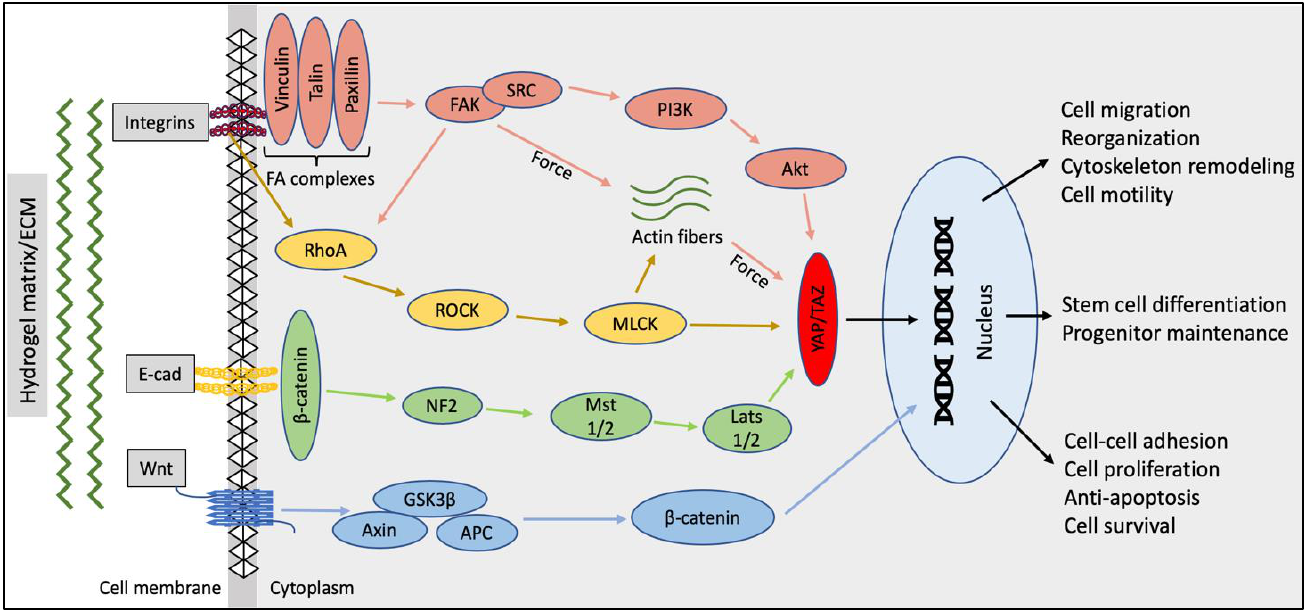
Figure 3. Schematic map of the key signaling pathways to be considered while designing hydrogel properties (binding sites, stiffness, pore size, architecture, etc.) for SG tissue engineering and their association with the cell fate and function [70 – 74].